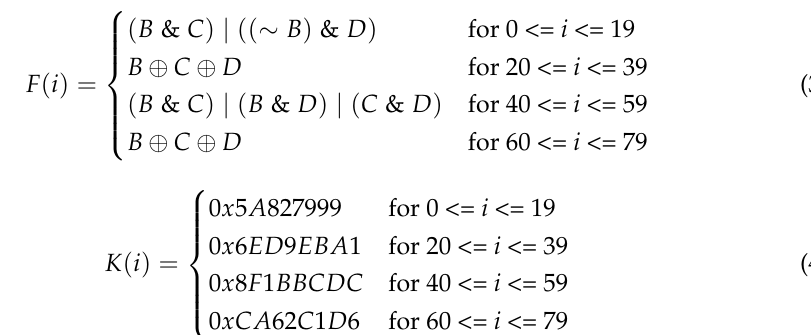
Function F and the value of variable K depend on the current round number as in Equations (3) and (4).